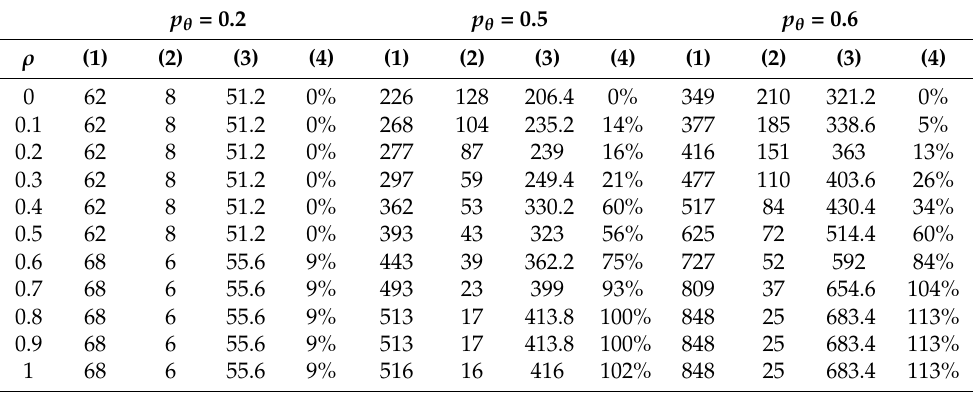
Table 11. Variation of TWWT , TWCTD and objective function in function of ρ , with different values of p θ . p θ =